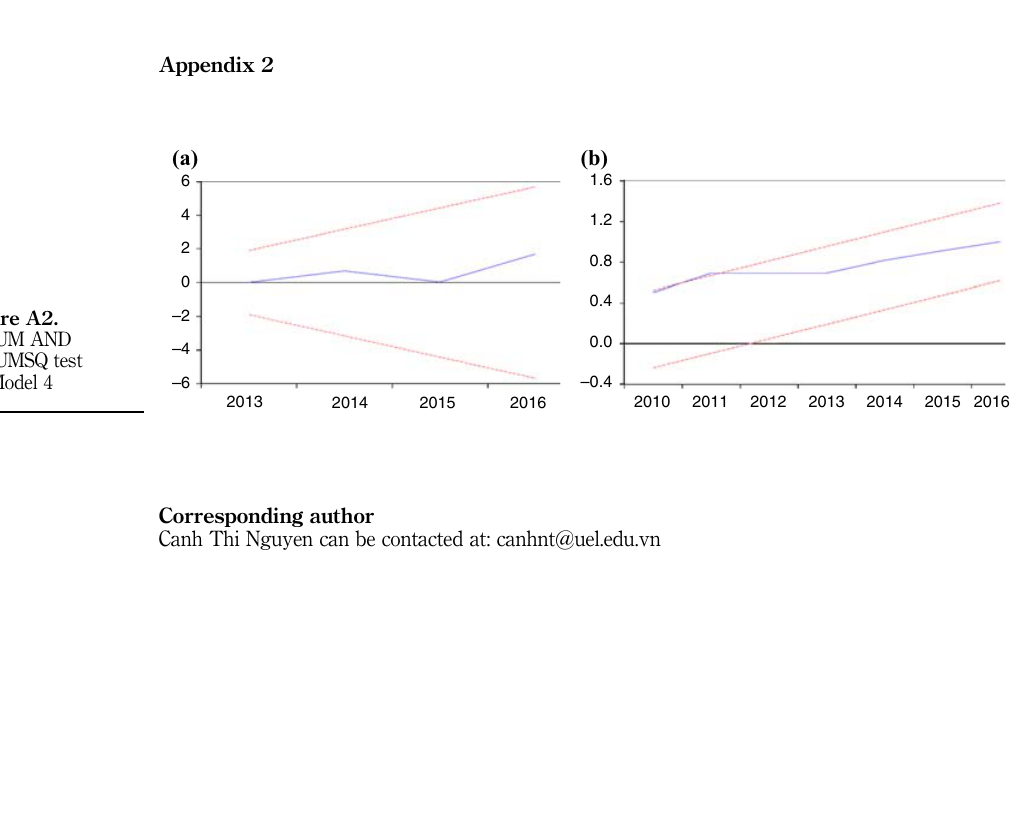
Figure A1. CUSUM and CUSUMSQ test for Model